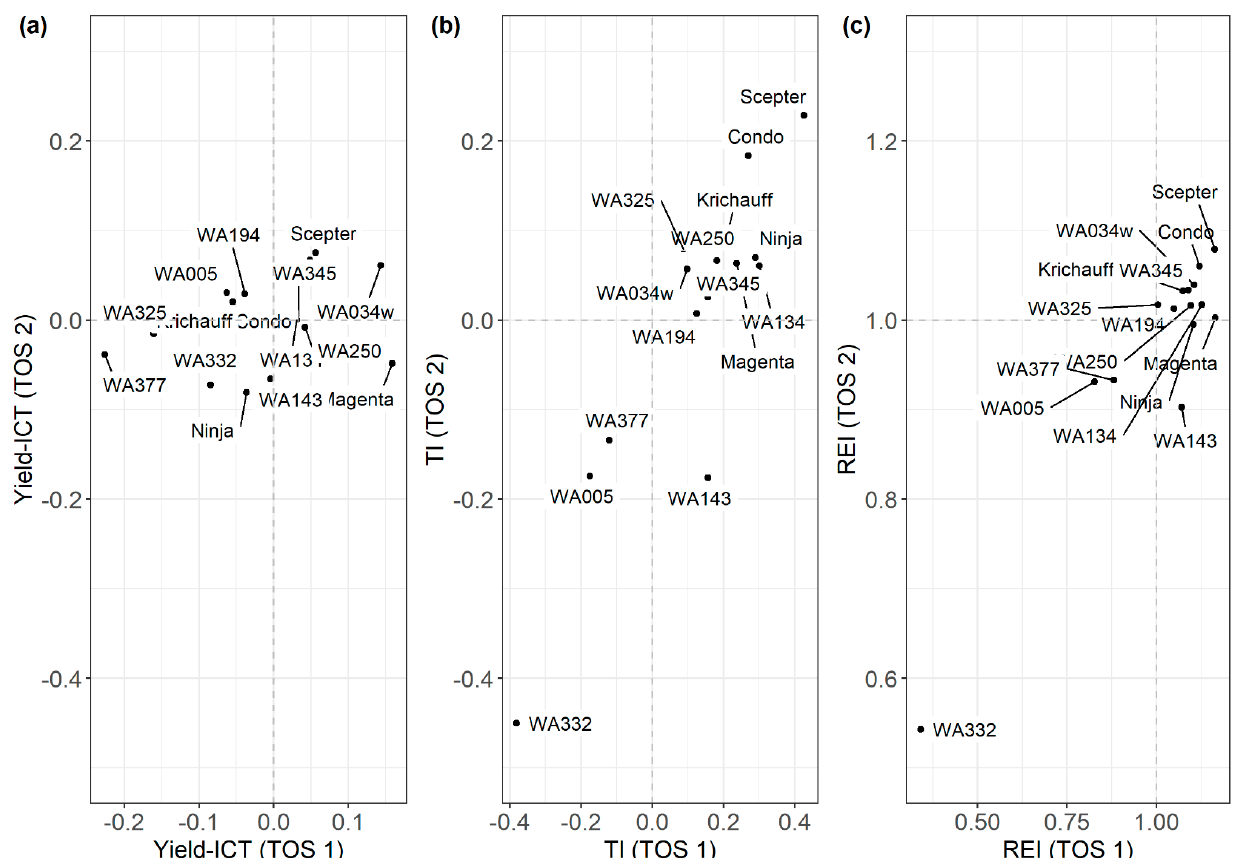
Figure 3. Yield-ICT ( a ), TI ( b ) and REI ( c ) comparison in the TOS2 vs. TOS1 matrix (the difference in scale is not meaningful. Data were taken from the 2019 field trial in sodic and noon-sodic soil. Considering both TOSs, only Scepter, Condo, WA034w and WA345 were tolerant to sodic soil (Figure 3a). On the other hand, WA332, WA377, WA325, WA143 and Ninja showed intolerance to sodic soil at both TOSs (Figure 3a).